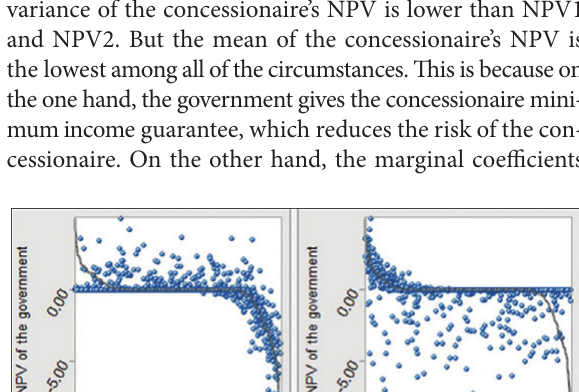
Standard Coefficient of Variance Minimum Deviation Variability